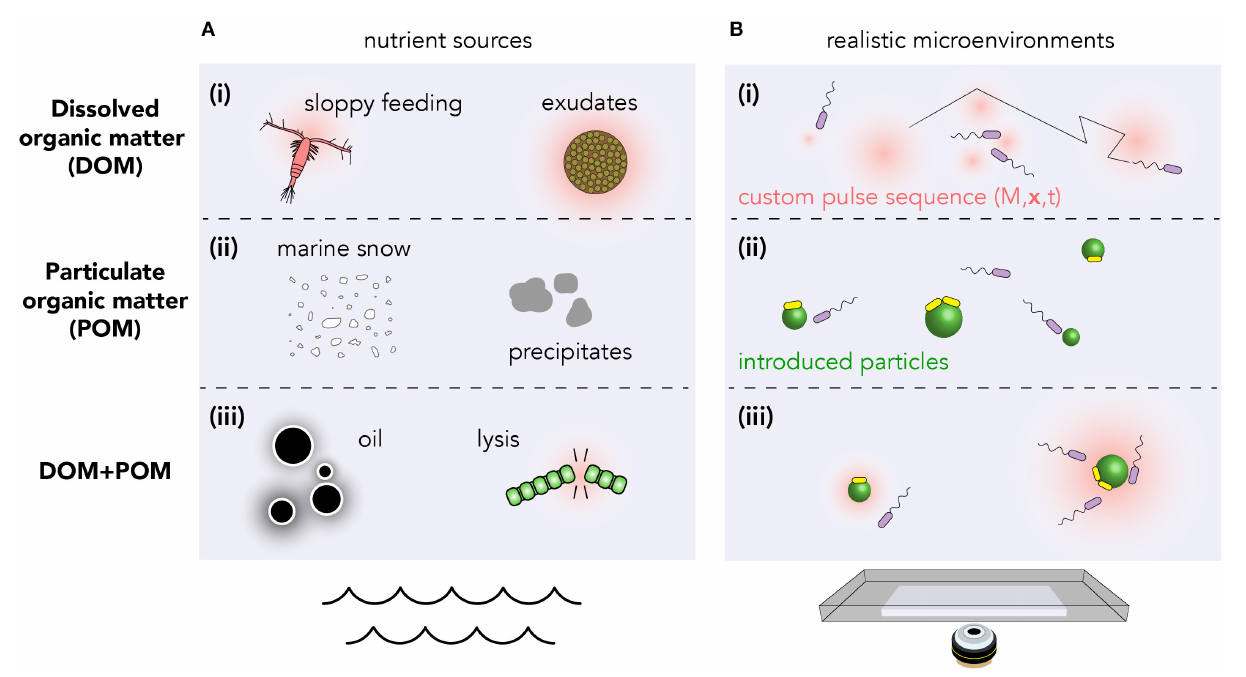
FIGURE 1 | Structured nutrient landscapes found in the ocean can be quantitatively reproduced in laboratory settings using microfluidics, photolysis of caged resources, and discrete nutrient particles. (A) Various biological processes produce resources which may be (i) dissolved, (ii) particulate, or (iii) a combination of both. (B) Realistic microenvironments can be recreated using (i) photolysis of caged compounds to produce custom DOM landscapes (Brumley et al., 2019; Carrara et al., 2020); (ii) spatial arrays of particles (e.g., chitin or alginate) (Datta et al., 2016); or (iii) both. Within these custom arenas, bacterial chemotaxis and population kinetics can be tracked over timescales from milliseconds to days. Transitions between planktonic (purple) and surface-attached bacteria (yellow) can also be quantified (Yawata et al., 2014).